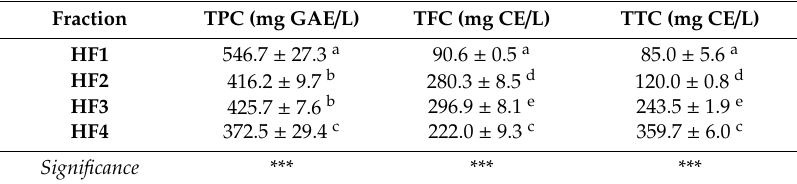
Table 2. Analysis of polyphenols present in Honduras CBS fractions